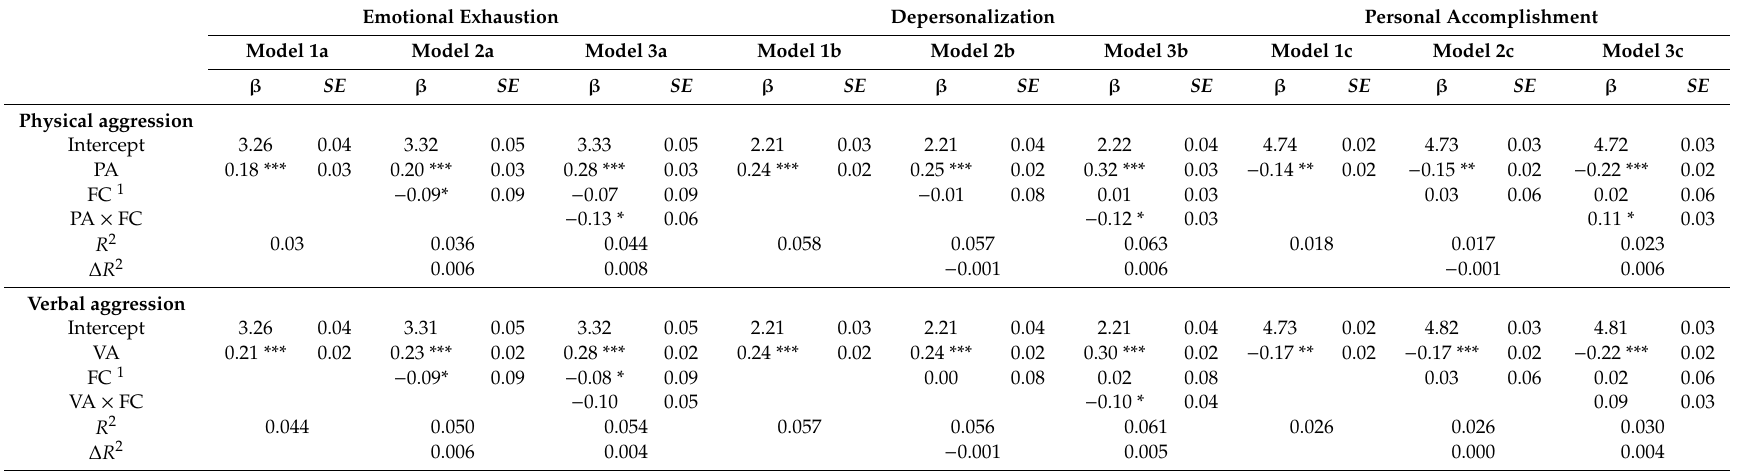
Table 2. Results of the regression